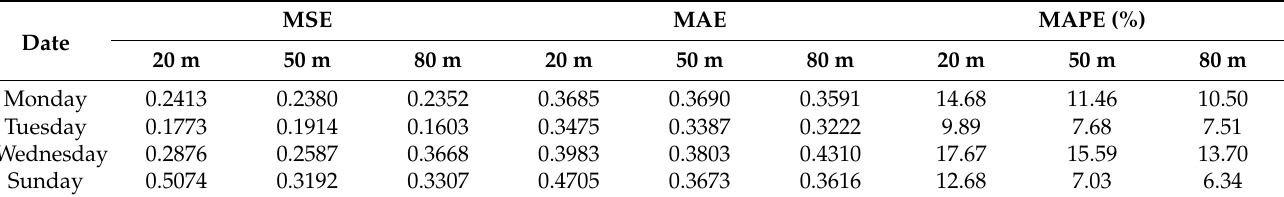
Figure 6. The bar chart for the evaluation index of the ELM network. Table 2. The evaluation index of the ELM